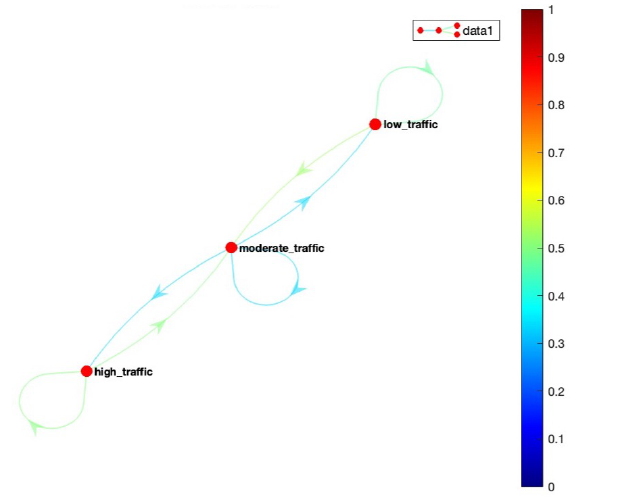
Figure 18. Markov Chain for traffic